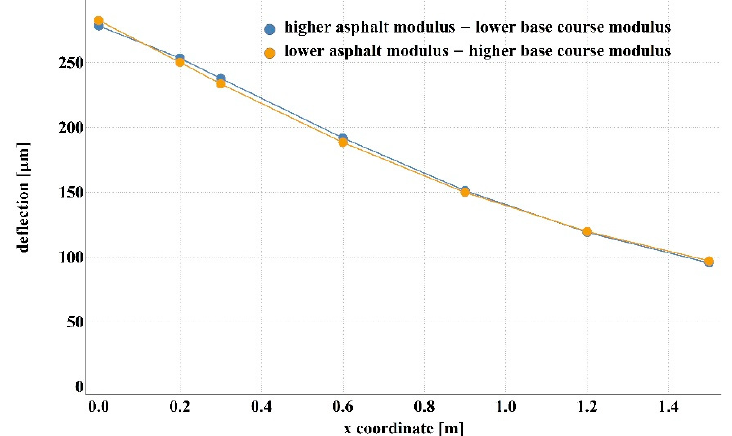
Figure 4. Deflection basin for the case with higher asphalt layer modulus—lower aggregate base course modulus and lower asphalt layer modulus—higher aggregate base course modulus.